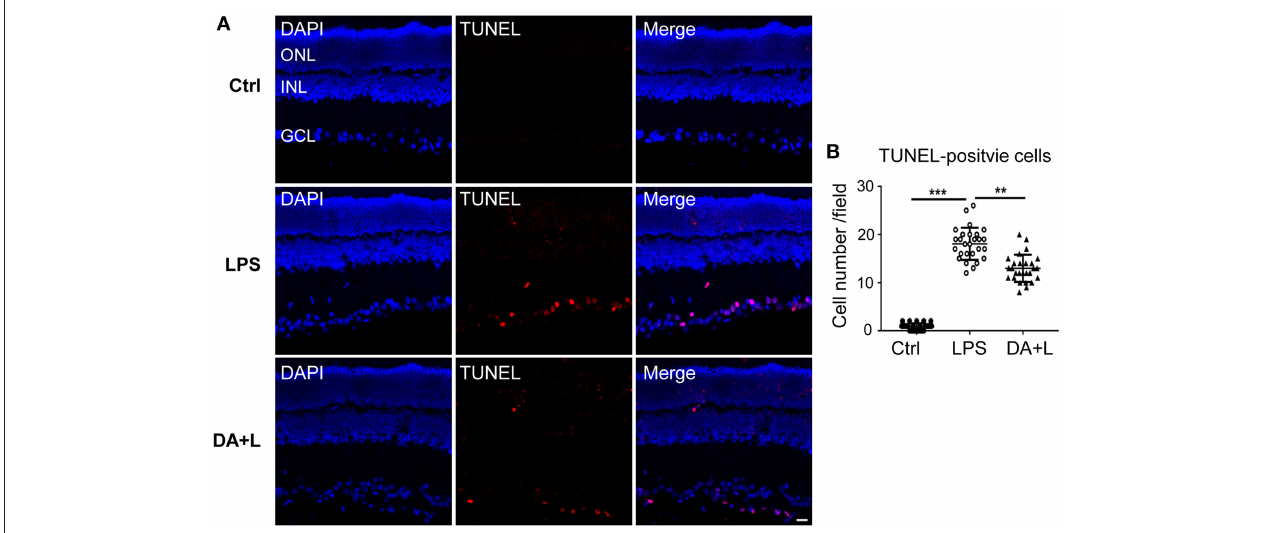
FIGURE 7 | Blocking of Notch1 signaling prevented RGCs from apoptosis in EIU rats. (A) Confocal images showed that many TUNEL-positive cells (red) were observed in the GCL 24h after LPS injection. DAPT treatment could remarkably reduce the number of TUNEL-positive cells (red). The nuclei were stained with DAPI (blue). Scale bar, 20 µ m. (B) The dot plots of TUNEL-positive cells. Total 27 retinal images in each group were used for statistical analysis. ** p < 0.01, *** p < 0.001 (one-way ANOVA). Ctrl, Control; DA + L, DAPT + LPS; ONL, outer nuclear layer; INL, inner nuclear layer; GCL, ganglion cell layer.